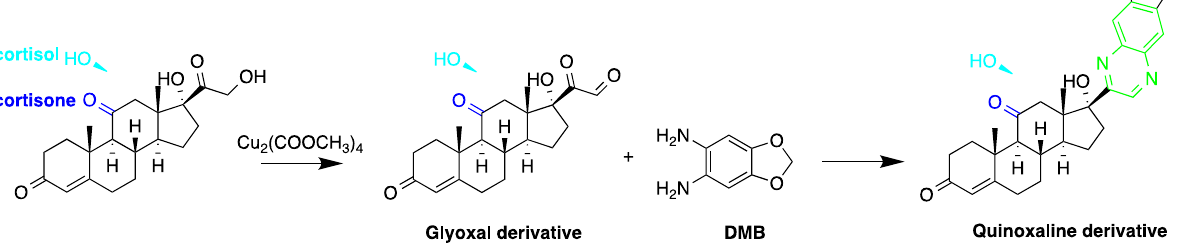
Figure 9. Fluorescent derivatization of ketol-containing corticosteroids to quinoxaline derivative. Cholesterol quantification is commonly required in the analysis of biosamples. A study described a simple and sensitive method for the determination of cholesterol and phytosterols, such as β -sitosterol in biosamples (e.g., saliva and urine matrices) and food samples (cow and soybean milk) after derivatization with naproxen acyl chloride in toluene (Figure 10). The method employed a C 8 column with a mixture of methanol, isopropanol, and water, achieving a LOD of about 25 nM (S/N = 3). The analysis of cholesterol and sitosterol is usually time-consuming, but using the method, a relatively short period of time was required since solvent concentration, evaporation, and replacement steps were not necessary [79].